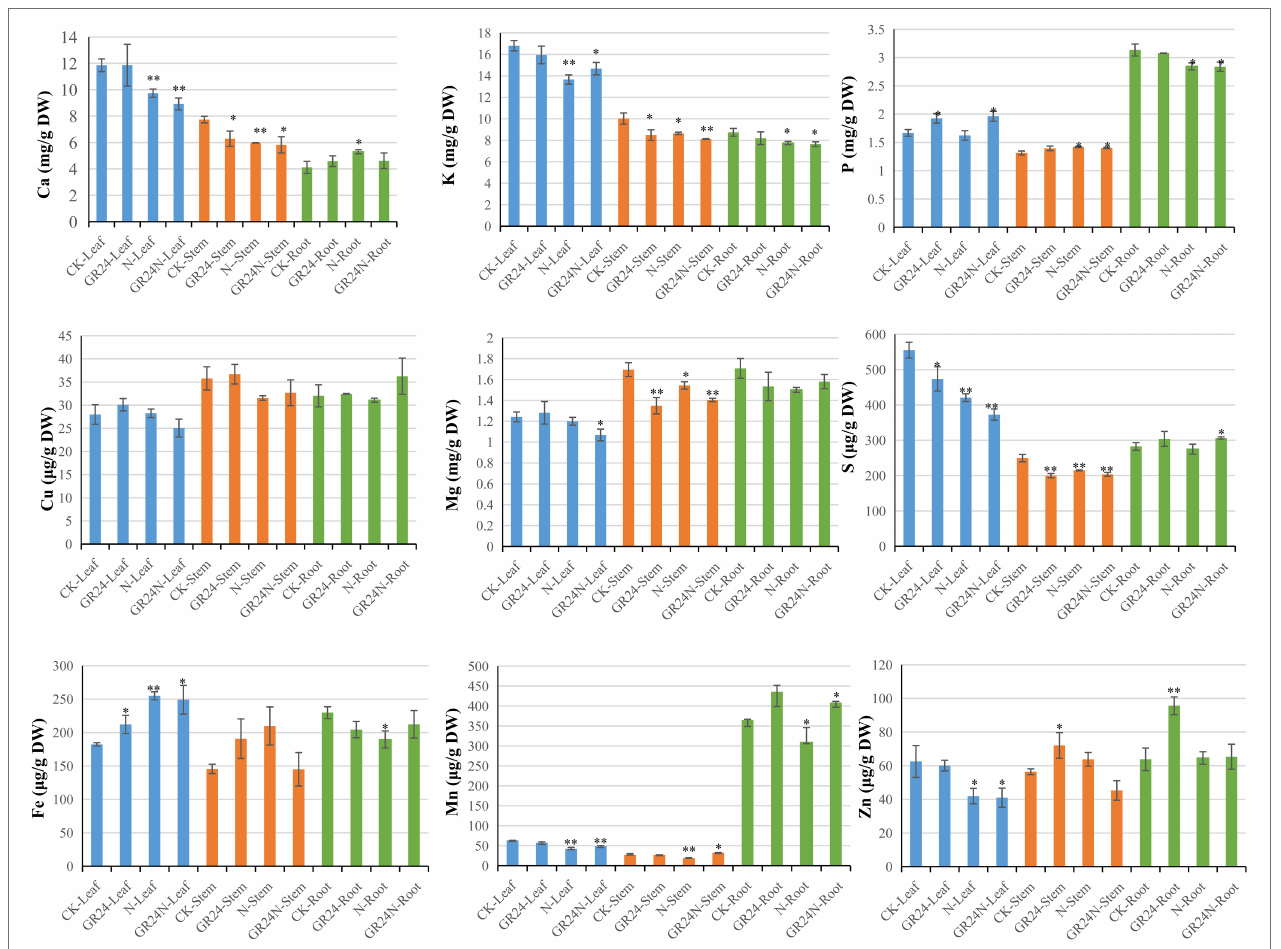
FIGURE 3 | The characteristics of nutrient elements contents in Torreya grandis after additional N deposition or GR24 treatments for two mouths. “ * ” represent p ≤ 0.05, using unpaired student t -test; “ ** ” represent p ≤ 0.01, using unpaired student t